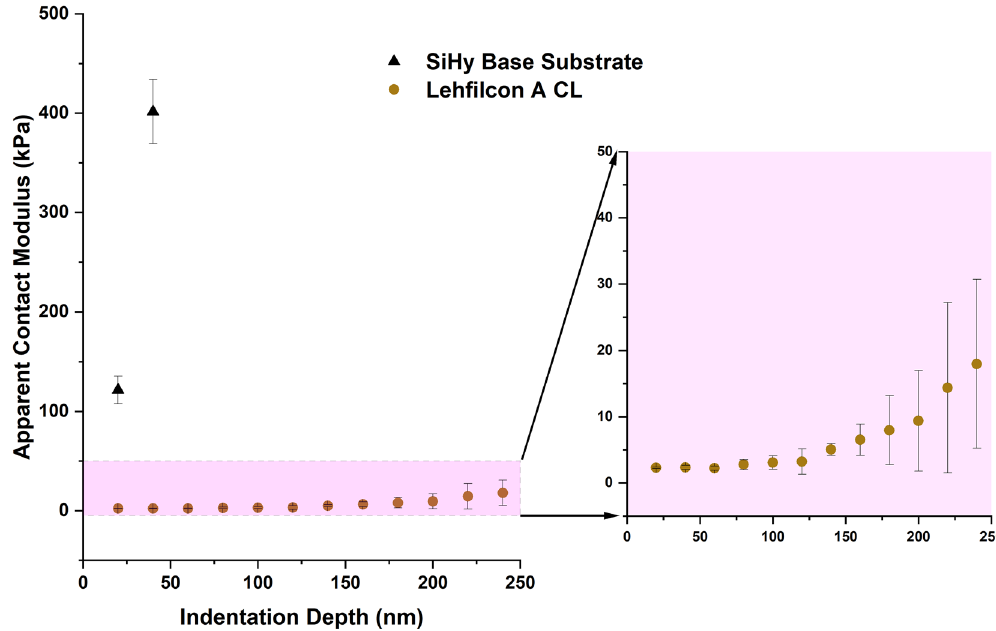
Figure 8. Apparent contact modulus (kPa) as a function of indentation depth (nm) for the lehfilcon A CL and the SiHy base substrate using the AFM nanoindentation method employing the cone-sphere geometry model for modulus